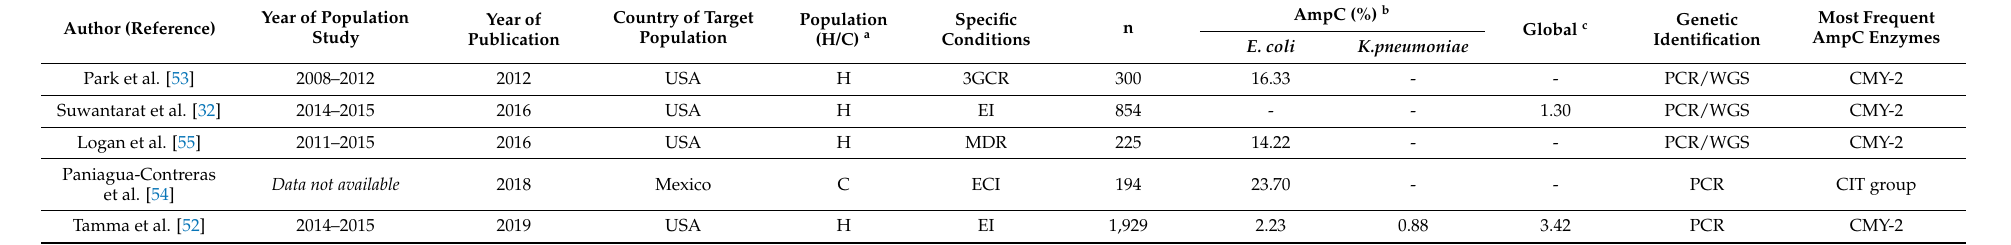
Table 3. Epidemiology of pAmpC-BLs in America (2010–2020).